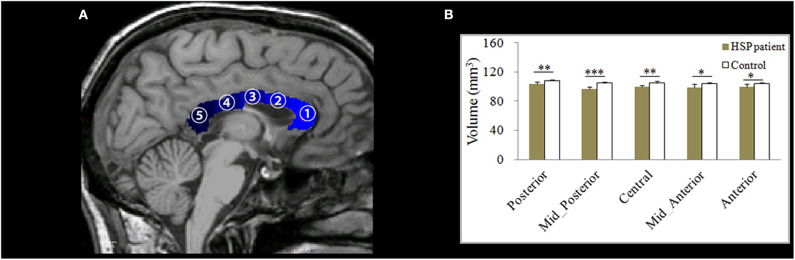
(A) An example of the division of the corpus callosum (shown in blue) into five segments on a T1-weighted image. (B) Differences in the mean volumes of the five subdivisions of the corpus callosum. *p < 0.05; **p < 0.01; ***p < 0.001.